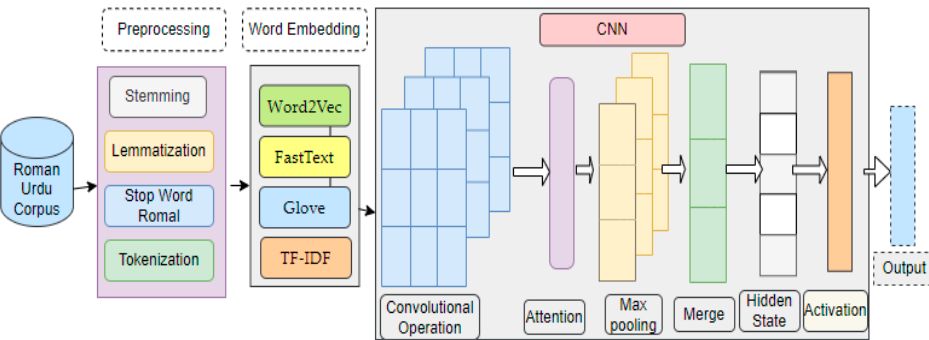
Figure 1. 4C-CNNAT for Roman Urdu Sentiment Analysis.